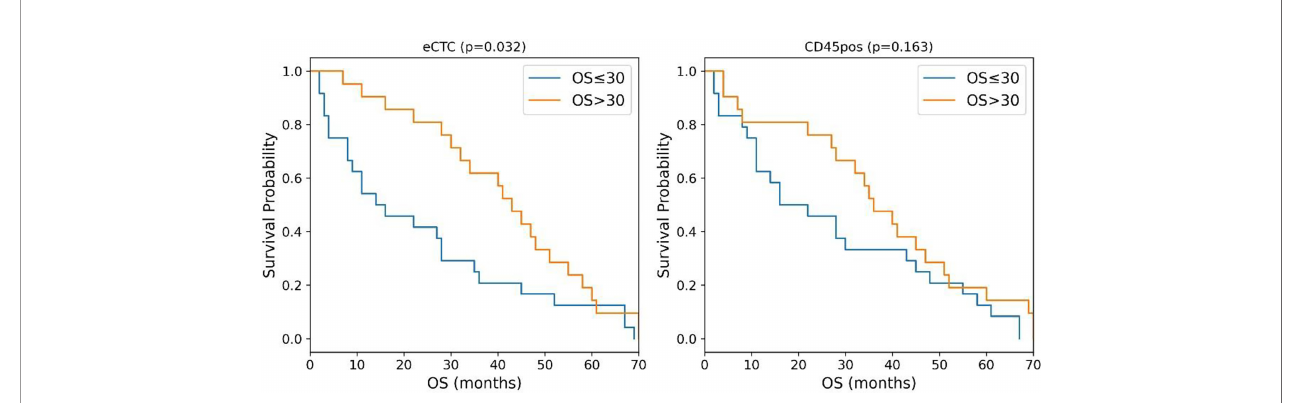
FIGURE 2 | Kaplan – Meier curves of MBC patients strati fi ed according to the circularity of eCTC (left) and CD45 positive cells (right). P-values were calculated by Log Rank test.